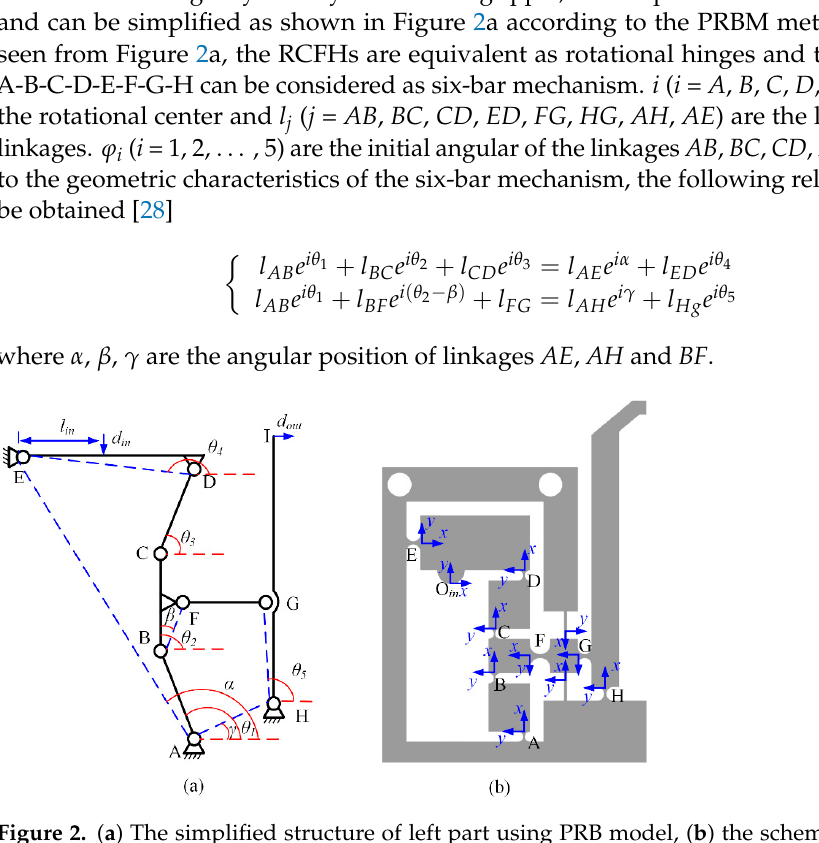
Figure 2. ( a ) The simplified structure of left part using PRB model, ( b ) the schematic diagram of left part. left